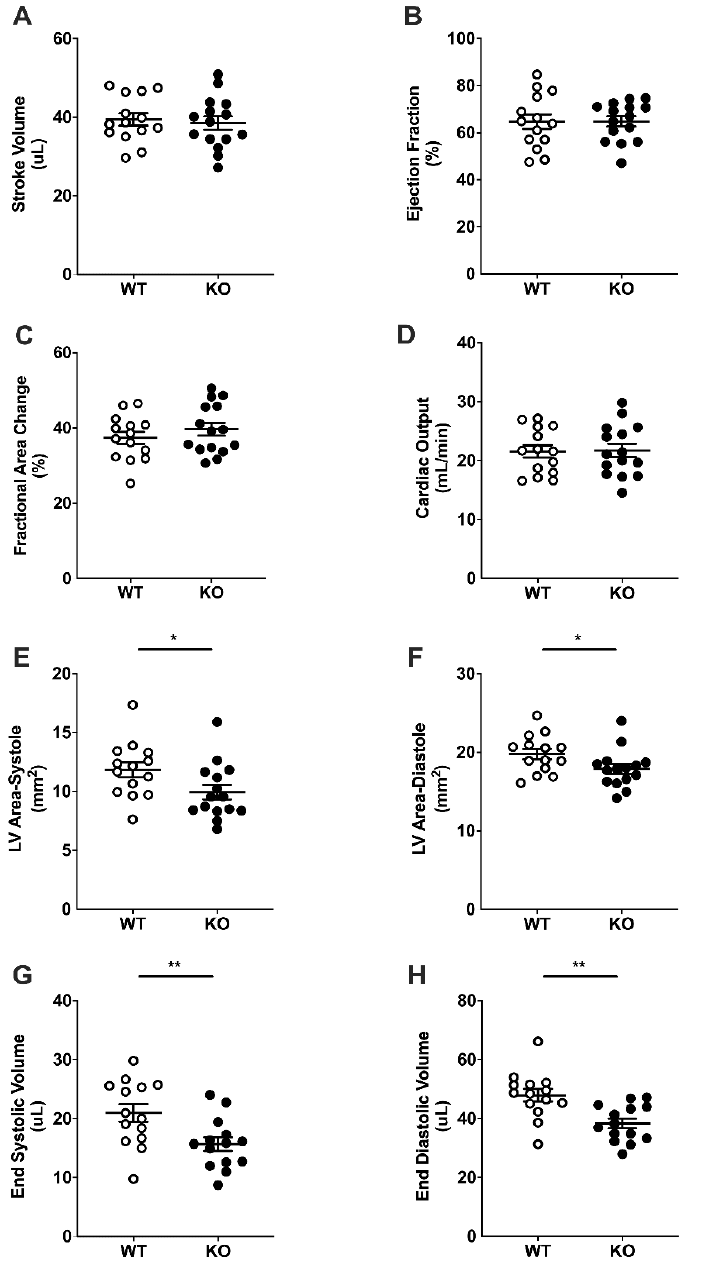
Figure 3. Basal cardiac dimensions and function by ultrasound echocardiography. Stroke volume (SV, A ), ejection fraction (EF, B ), fractional area change (FAC, C ), cardiac output (CO, D ), left ventricular systolic ( E ) and diastolic ( F ) areas, end systolic volume (ESV, G ) and end diastolic volume (EDV, H ) in 8-week-old female WT (white, n = 14) and KO (black, n = 14) mice. Student’s t -test. Data are mean ± SEM. * p < 0.05, ** p <